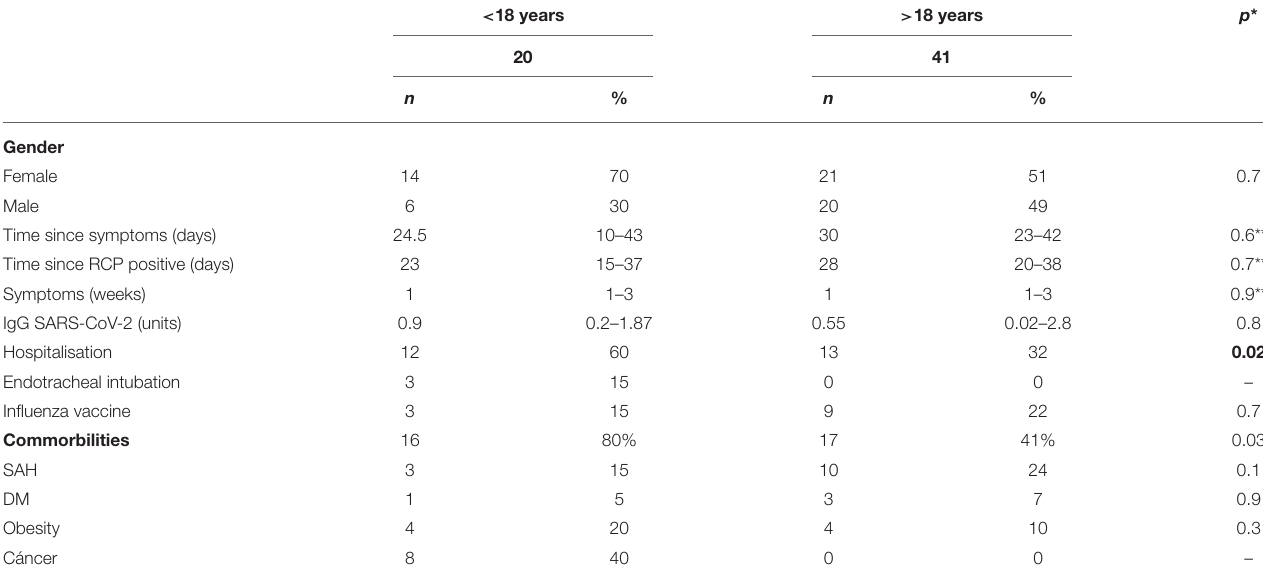
TABLE 2 | Differences according to age